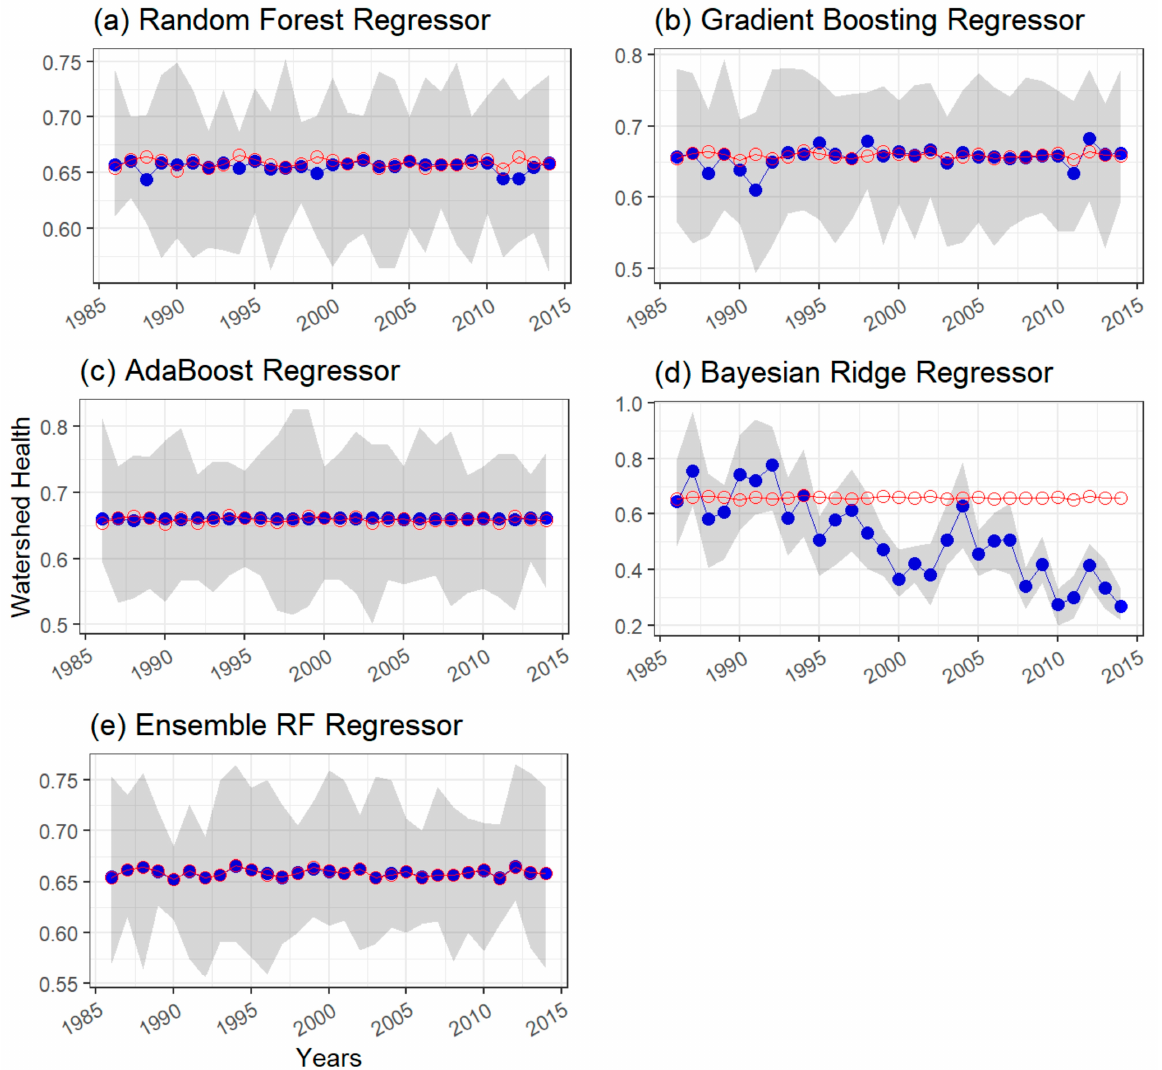
Figure 7. Same as Figure 5. Time series comparison of watershed health (with respect to nitrite + nitrate) estimated from observations as in Mallya et al. [48] at USGS-NAWQA station 04193500 Maumee River at Waterville, OH, which was part of the test set versus ML model predictions using ( a ) random forest regressor, ( b ) gradient boosting regressor, ( c ) AdaBoost regressor, ( d ) Bayesian ridge regressor, and ( e ) ensemble RF regressor.